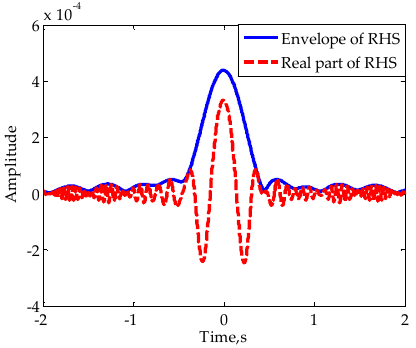
Figure 13. Simulated RHSs of vehicle model for baseline lengths of 400 m.